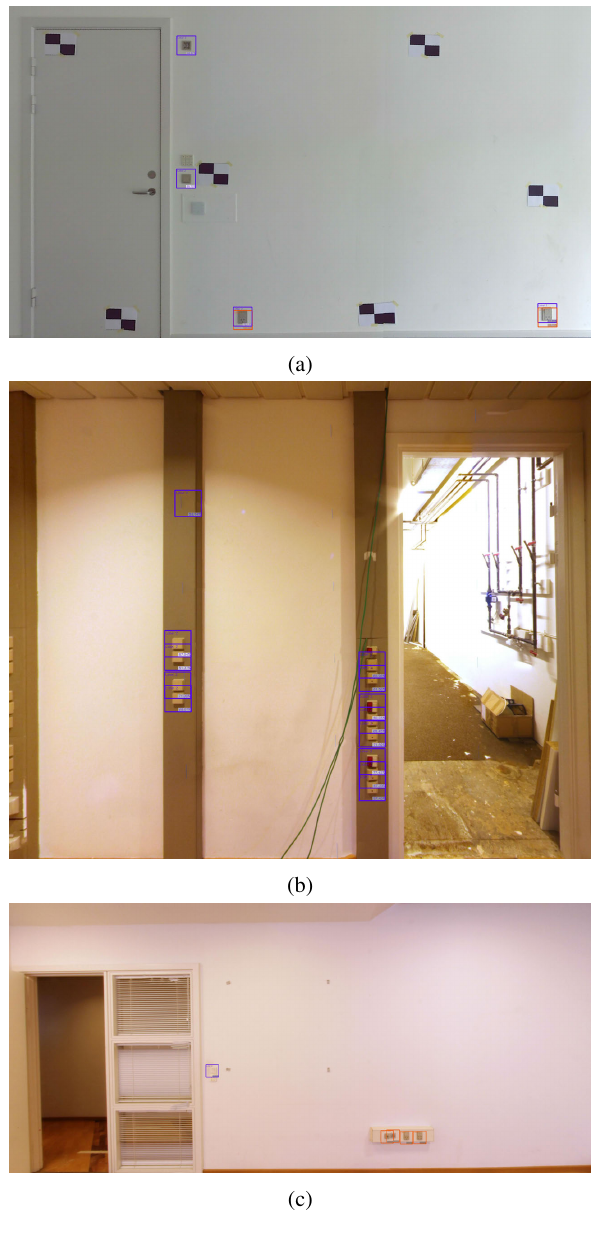
Figure 10: We use computer vision methods to train a classifica- tion system and detect electrical appliances, in this case switches. The two trained classes correspond to switches (violet rectangles) and sockets (orange